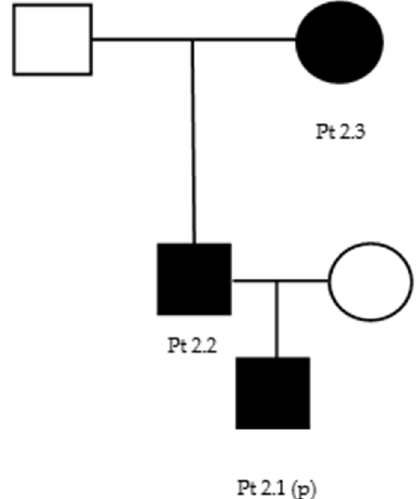
Figure A2. Family 2 pedigree.